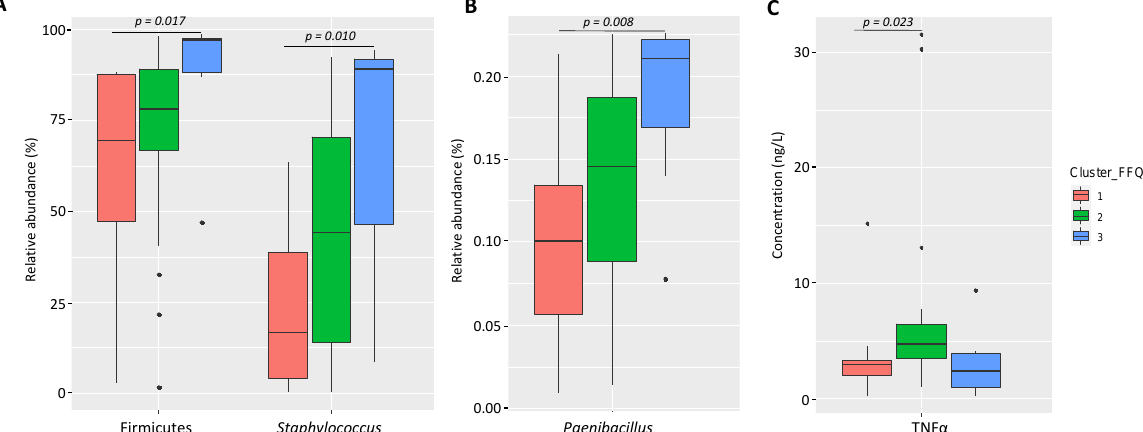
Figure 2. Box-plots showing the consumption of each food group (servings/week) according to the dietary habits of the women participating in the study. In the box-plots, the box represents the values of the interquartile ranges, and the median is represented as a line in the box. Outliers are represented as dots. Cluster 1 ( n = 19) is coloured in red, Cluster 2 ( n = 22) in green and Cluster 3 ( n = 8) in blue. The dairy products group includes milk, cheese and yogurt; the cereals group includes bread, pasta and rice, and the fish group includes fresh tuna, canned tuna, salmon, swordfish and other fish.